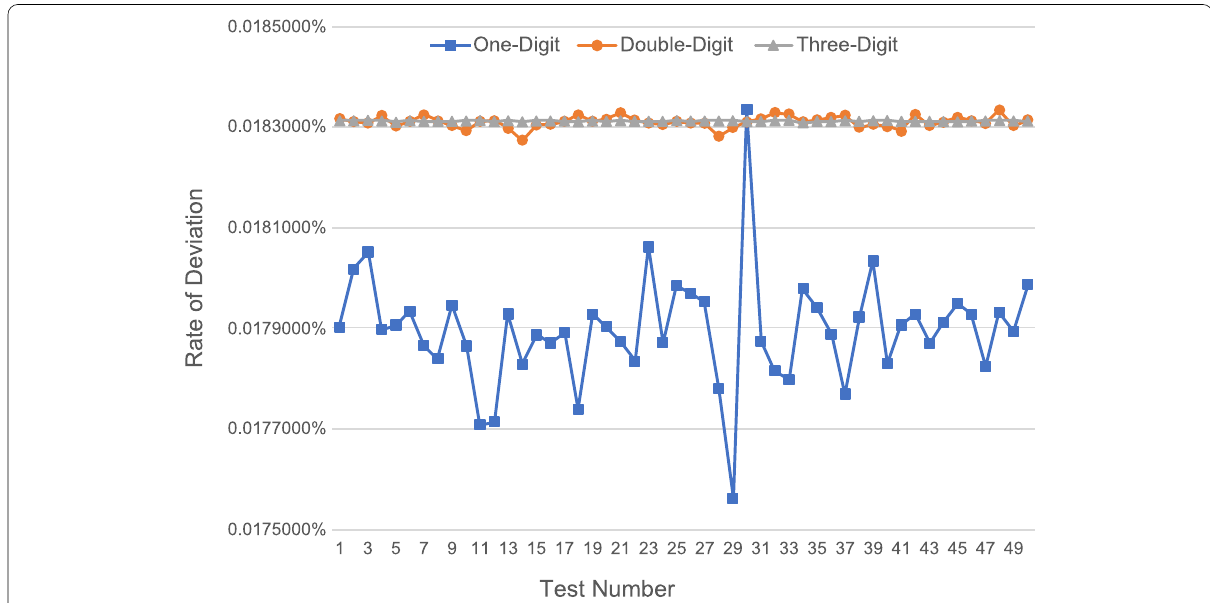
Fig. 6 Variable error rate of different